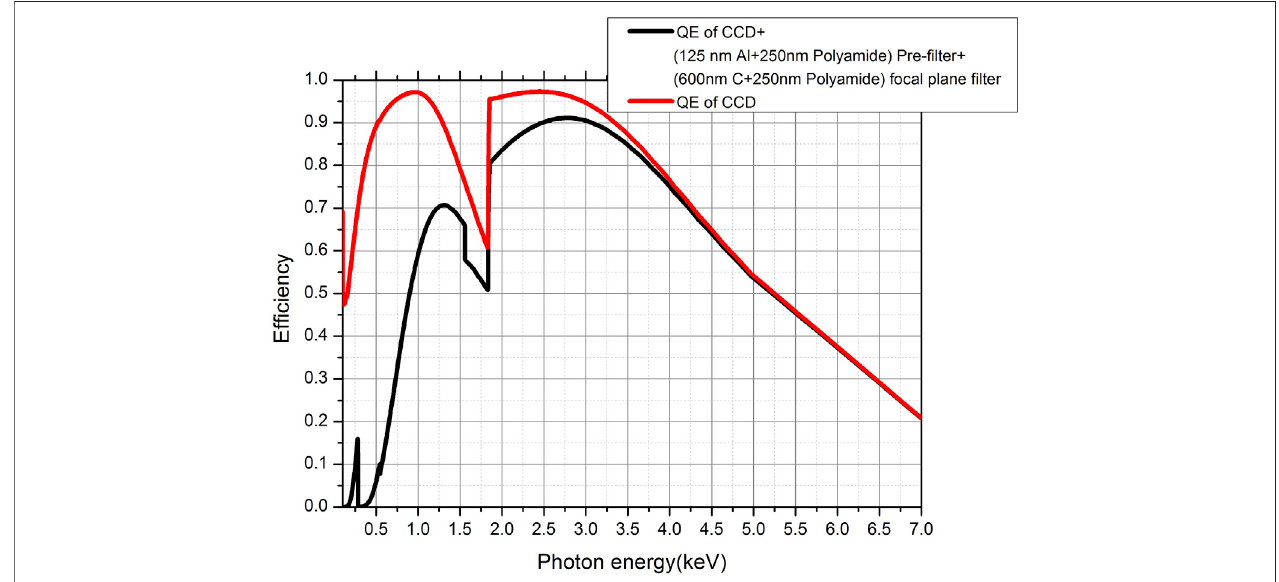
FIGURE 2 | Quantum ef fi ciency of the detector and the modi fi cation introduced by light fi lters.